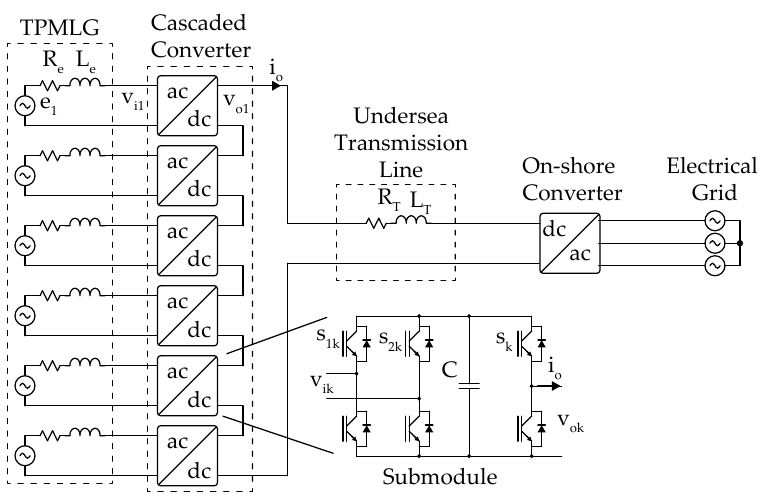
Figure 4. Cascaded inverter and grid